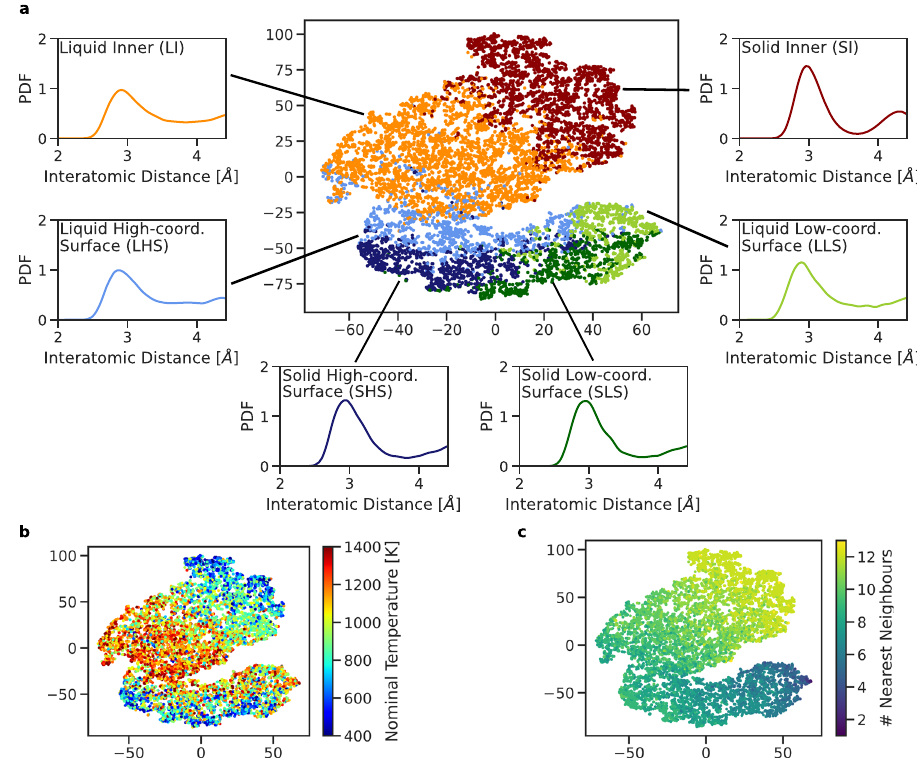
Fig. 1 Features of the six classes of local atoms environments identi fi ed through clustering. Visualization of the hierarchical k-means clustering results for MD simulations of Au nanoparticles with 147, 309, 561, 923, 2869, and 6266 atoms, carried out using the ML-FF trained on rPBE-DFT data. a First and second component ( x - and y -axis) of the t-sne projection of the atomic expansion coef fi cients of 10 4 local atomic environments randomly sampled from melting MD simulations. The colours label the six classes assigned by the hierarchical k -means clustering algorithm, as de fi ned in the main text. The normalized average pair-distance distribution function (PDF) belonging to each class is shown and coloured accordingly. b , c Same t-sne projection as in ( a ). In ( b ), the colours indicate the nominal simulation temperature at which the local atomic environment was taken from; in ( c ), the number of nearest neighbours (#NNs) was computed using a cut-off of 3.6 Å